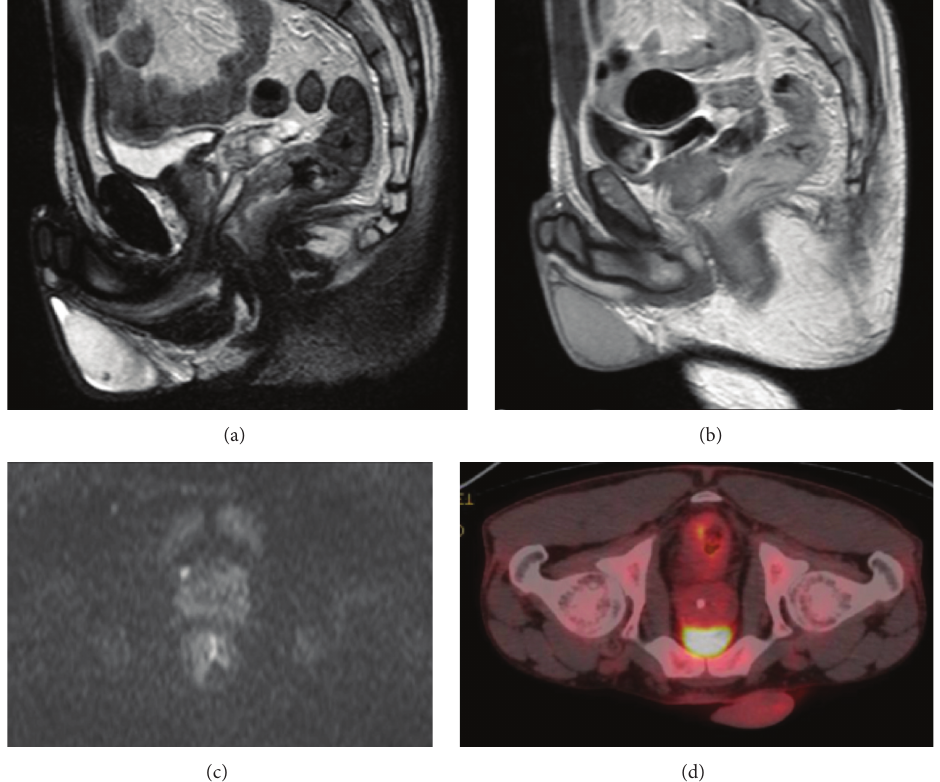
Figure 3: (a) T2 weighted sagittal plan with isointense rectal wall thickness; (b) T1 weighted sagittal plan after gadolinium administration with homogeneous contrast enhancement of the rectal walls; (c) Axial diffusion-weighted image (𝑏 = 1000) with no hyper intensity of the rectal wall; (d) 18F FDG PET-CT with focal FDG accumulation in the rectal